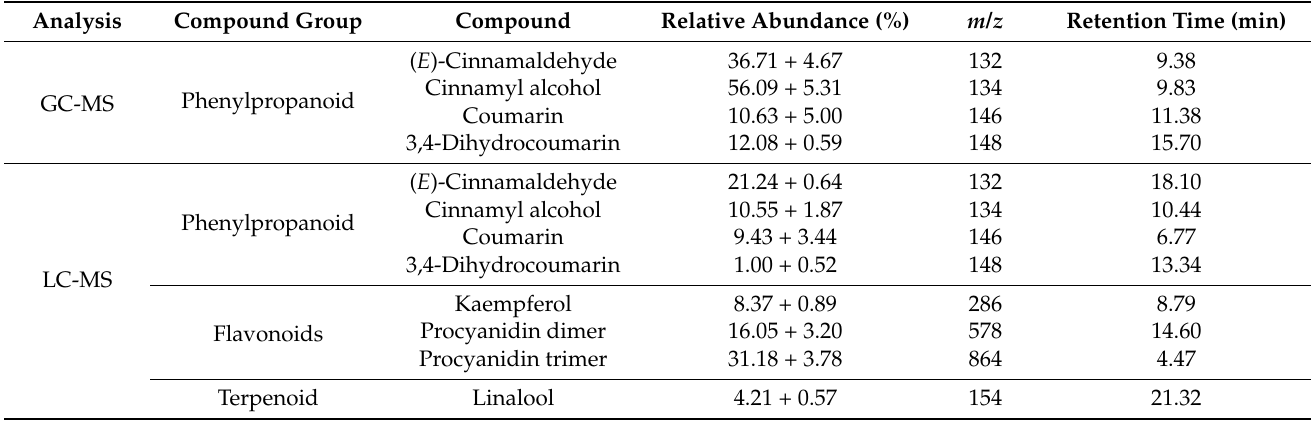
Table 4. Chemical constituent analysis of large-scale EtOH extract of cinnamon by GC-MS and LC-MS. Identification was based on their specific m / z values and comparison to literature data and MS